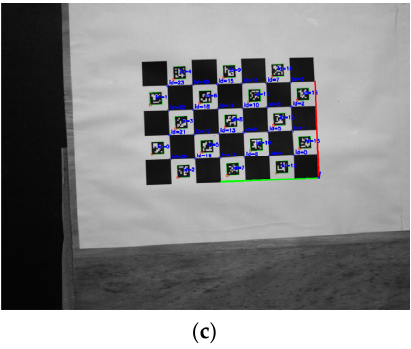
Figure 10. ( a ) Calculation of camera external parameters based on ArUco Marker; ( b ) Calculation of camera external parameters based on checkerboard; and ( c ) Calculation of camera external parameters based on ChArUco board.